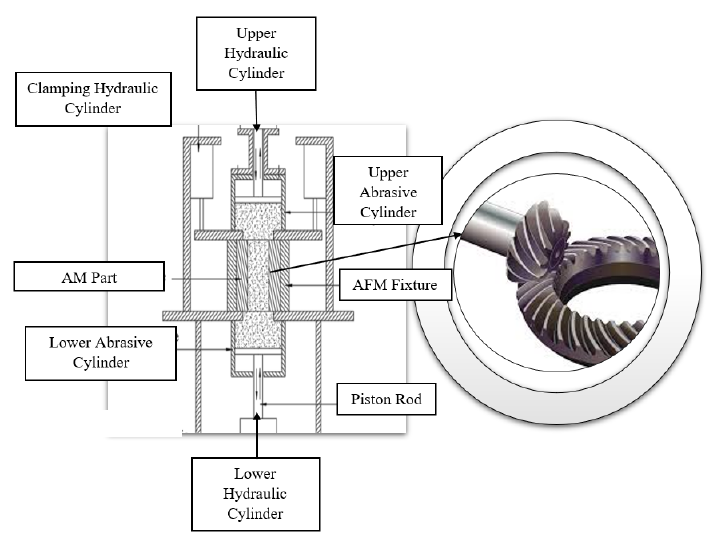
Figure 7. Schematic of two-way AFM